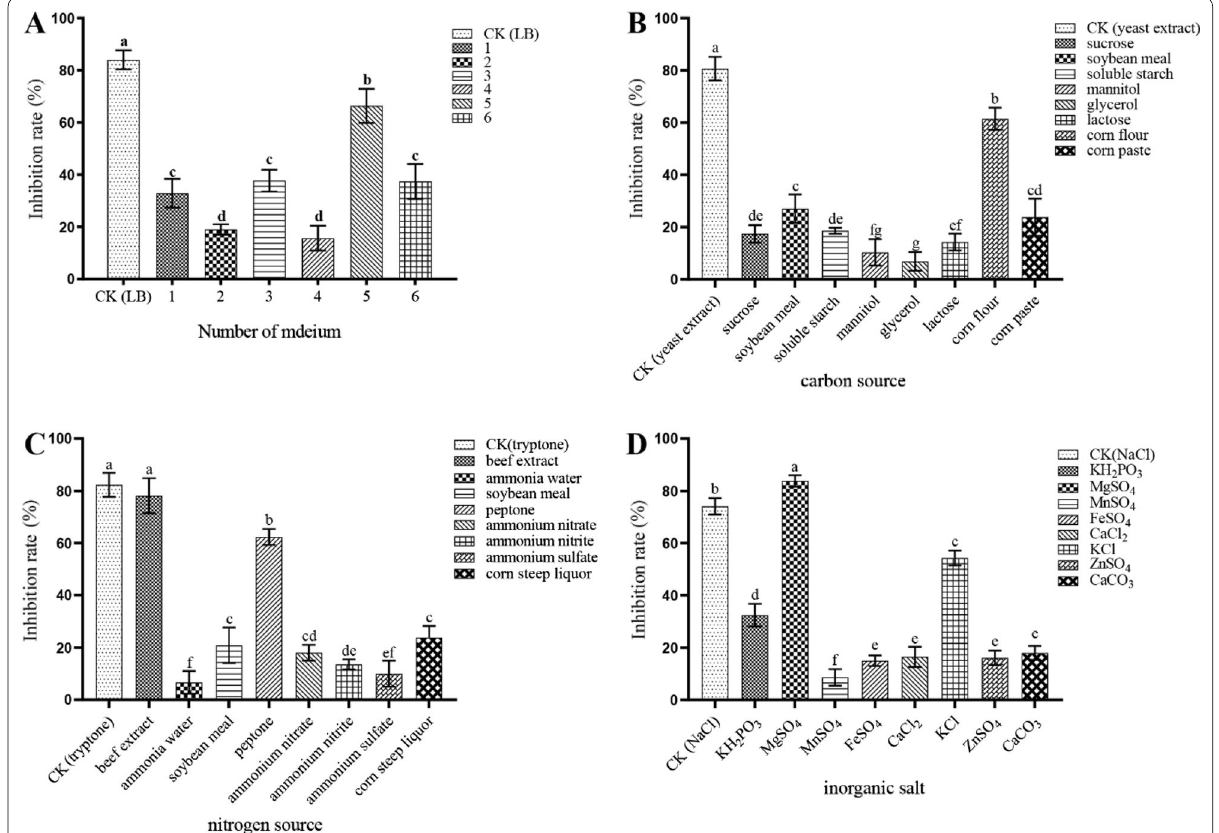
Fig. 1 Single‑factor test for screening fermentation media of Bacillus pumilus HR10 with different basal media ( A ), carbon sources ( B ), nitrogen sources ( C ) and inorganic salts ( D